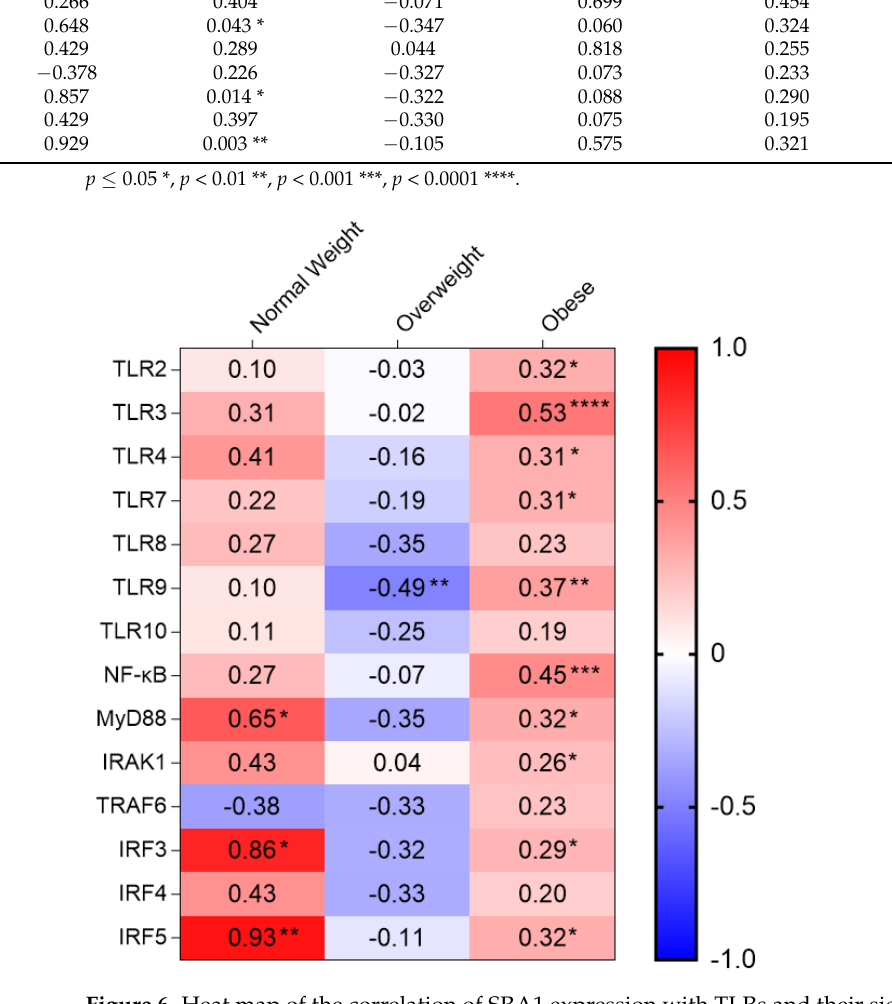
Figure 6. Heat map of the correlation of SRA1 expression with TLRs and their signaling molecules in adipose tissues obtained from NW, Overweight and Obese. p ≤ 0.05 *, p ˂ 0.01 **, p ˂ 0.001 ***, p ˂ 0.0001 ****.